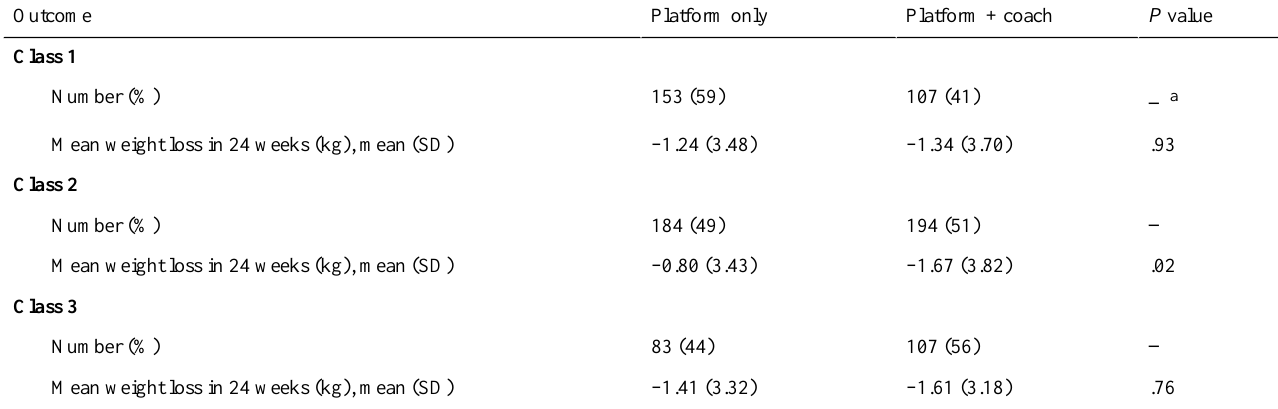
Table 5. Differences in weight change at 24 weeks by